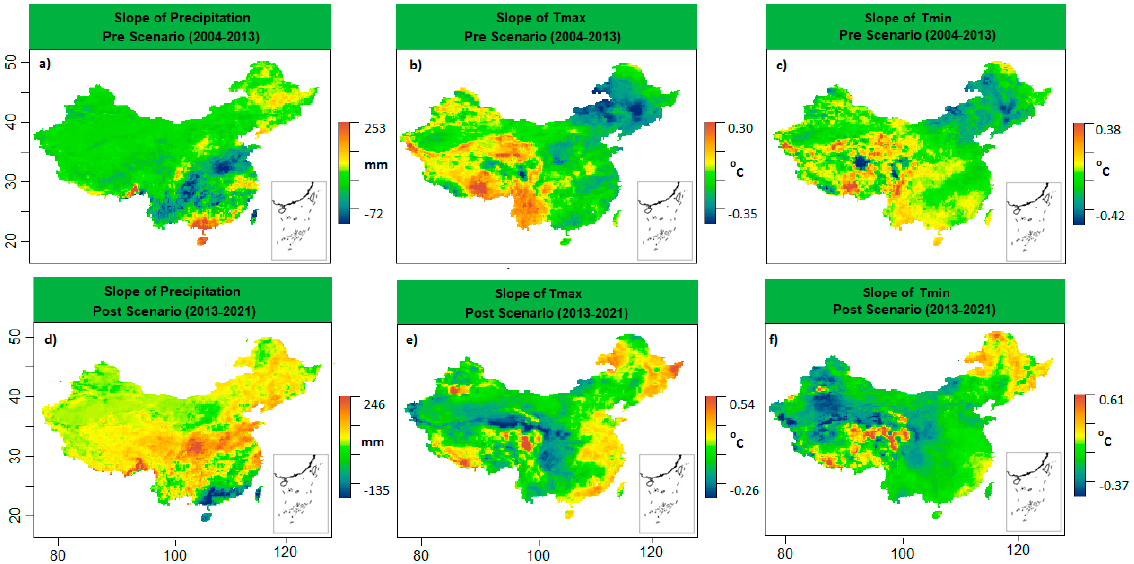
Figure 8. Slope of climatic variables for the pre- ( a , b , c ) and post- ( d , e,f ) scenarios over China.